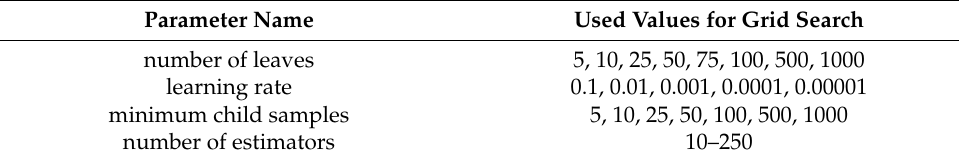
Table 6. Parameter search space for light GBM classifier.